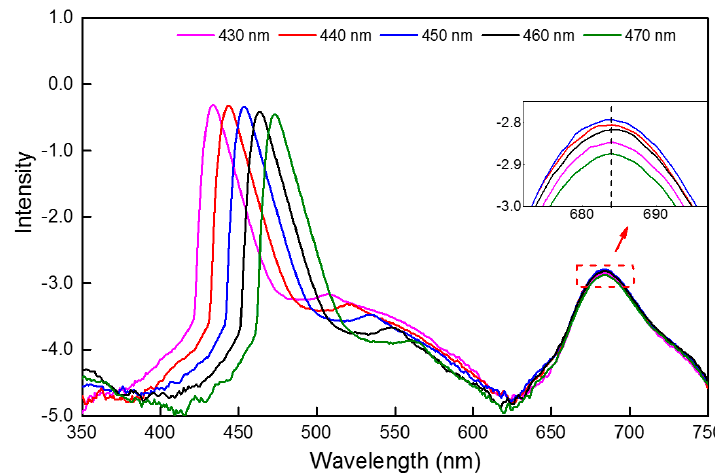
Figure 2. Emission spectra of Heterosigma akashiwo under various spectrums of lasers.